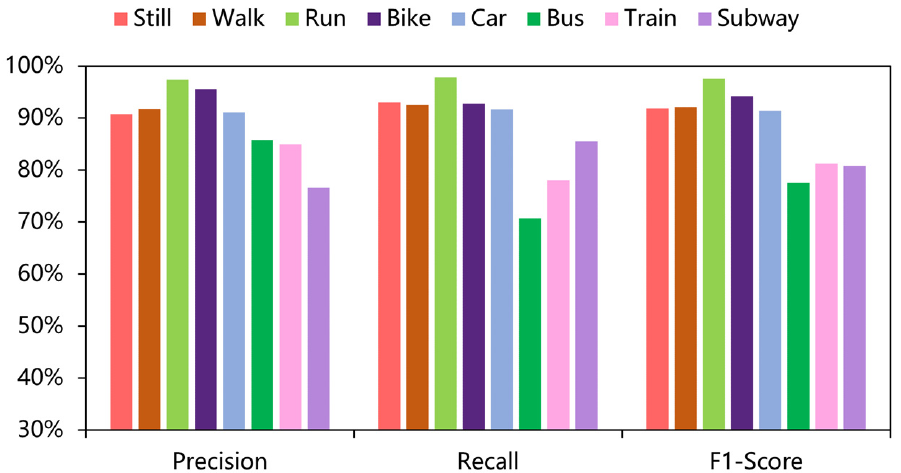
Figure 11. Precision, recall, and F1-scores of the eight classifications of the T2Trans model on the HTC dataset.